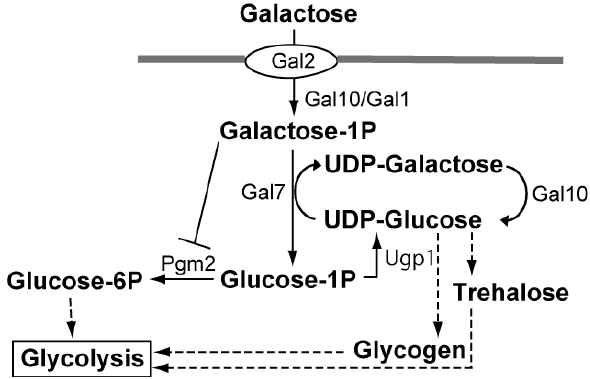
Figure 4. Galactose metabolism in S. cerevisiae [67]. Dashed arrows include several reactions. Details are described in the text.